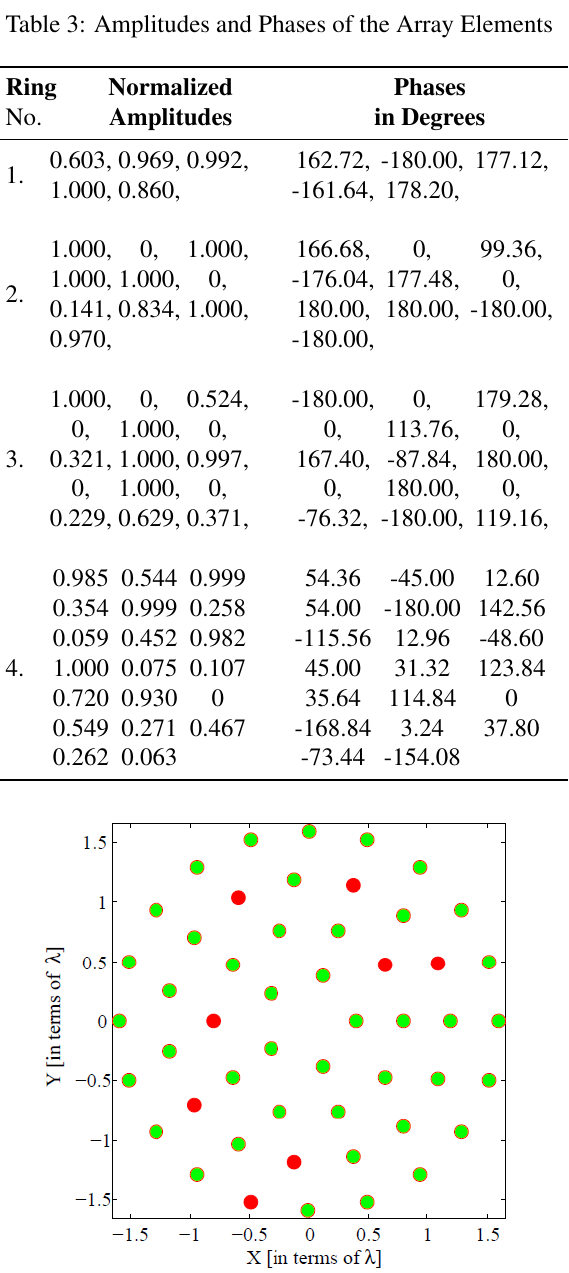
Table 4: Obtained results for scanned Flat-top pattern in arbitrary ϕ planes